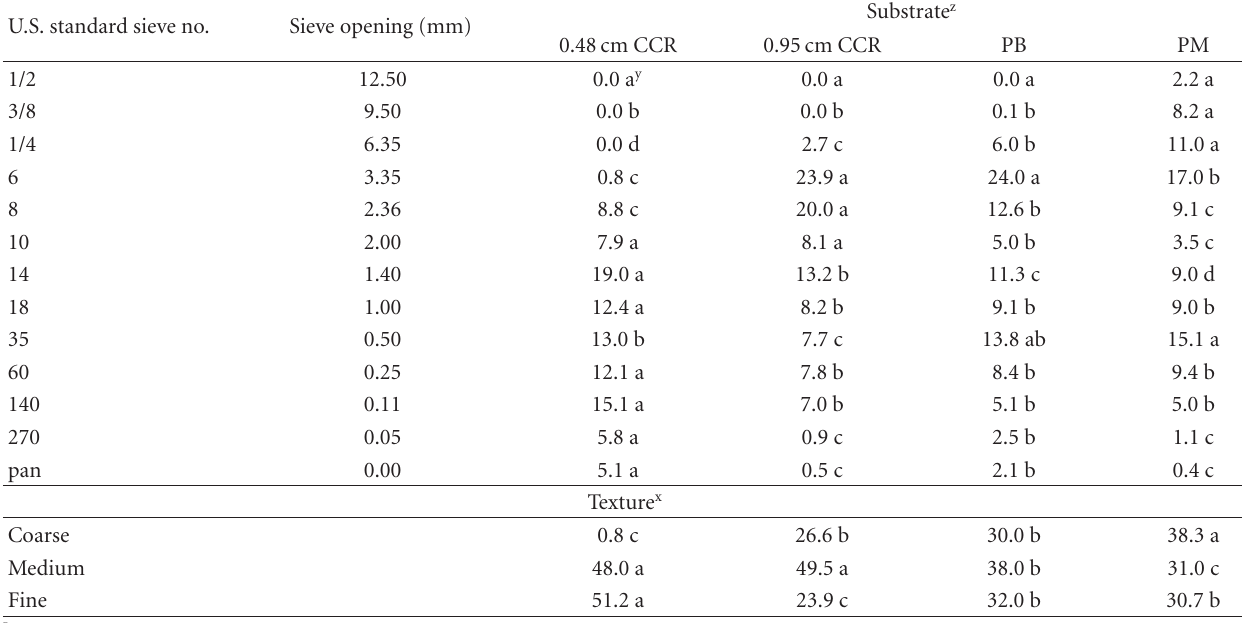
Table 2: Particle size analysis of clean chip residual, pine bark, and peatmoss substrates. U.S. standard sieve no.